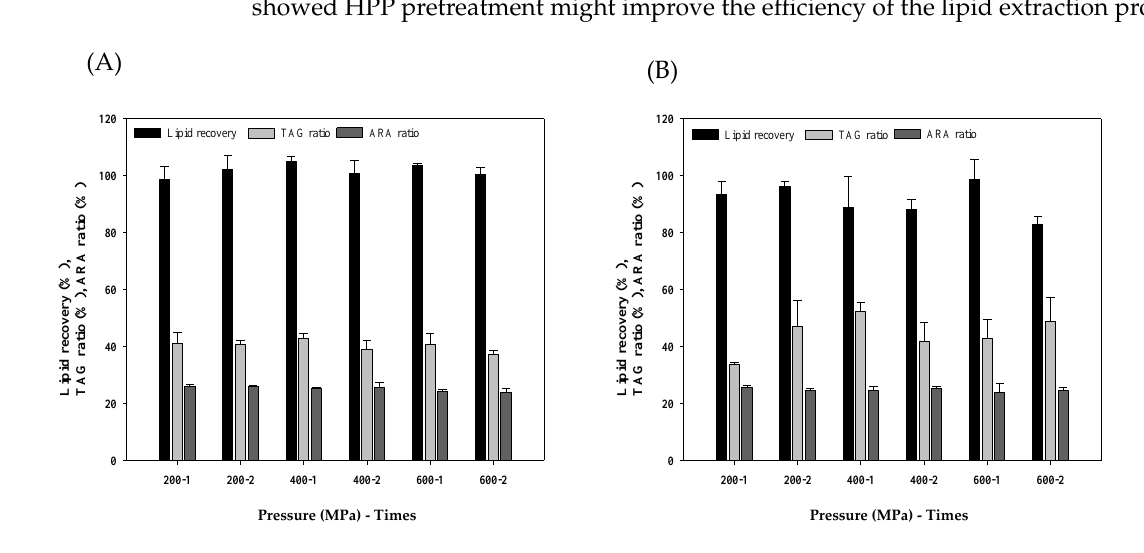
Figure 1. Lipid recovery, TAG ratio of dry matter and ARA ratio of total fatty acid by HPP treatment on M. alpina FU30797 by different pressure (MPa) and times of treatment. Different pressure medium ( A ) water, ( B ) ethanol. ( n = 3).